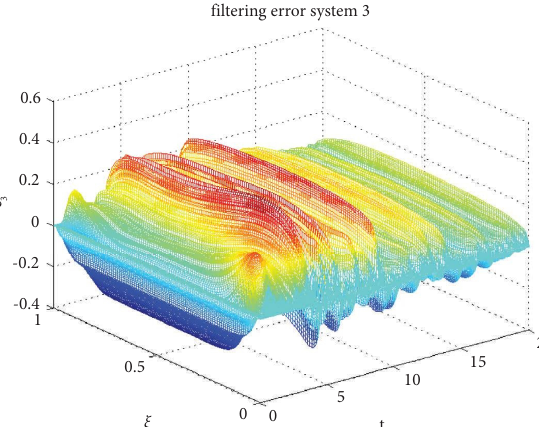
Figure 5: Filter error system development for flter